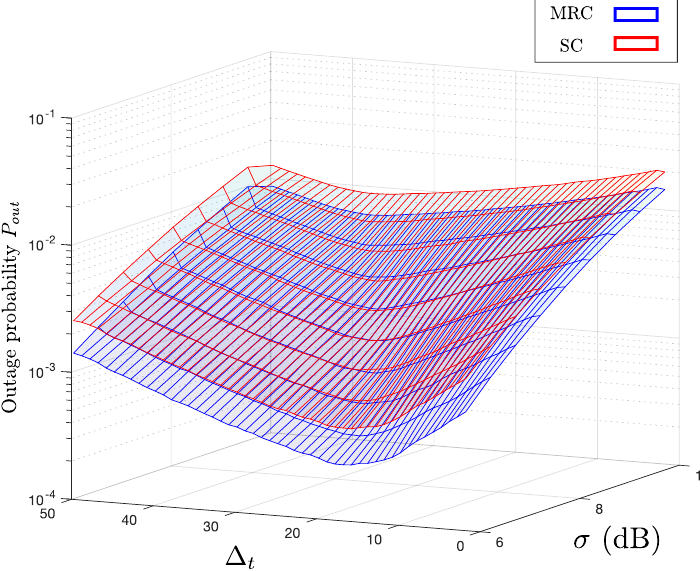
Figure 5. Outage probability P out with different ∆ t and σ , when γ th = 10 − 3 , l = 30 m, P T = 50 dB, and n = 4.